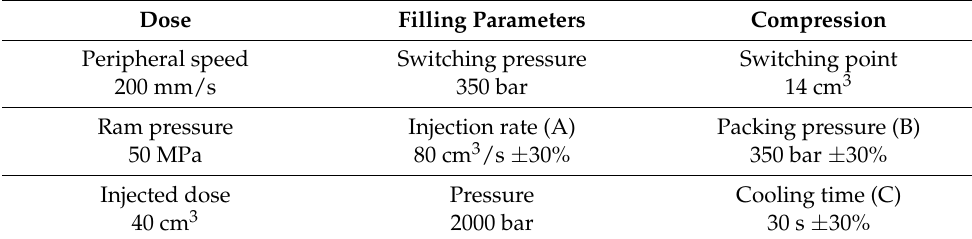
Table 3. Parameters of injection-molding process.